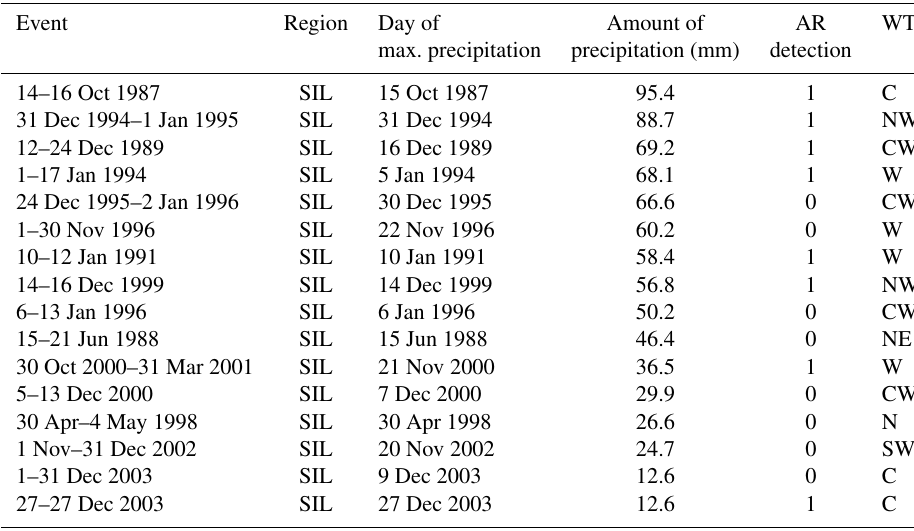
Table A3. FEs included in the analysis, listed in descending order of precipitation amount for the SIL region.